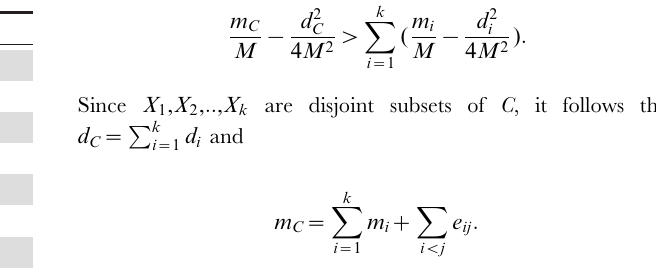
Table 2. Algorithm 2.